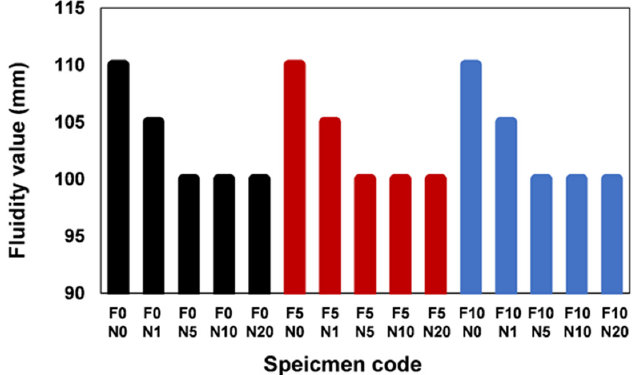
Figure 2. Fluidity values of alkali-activated slag (AAS) composites.